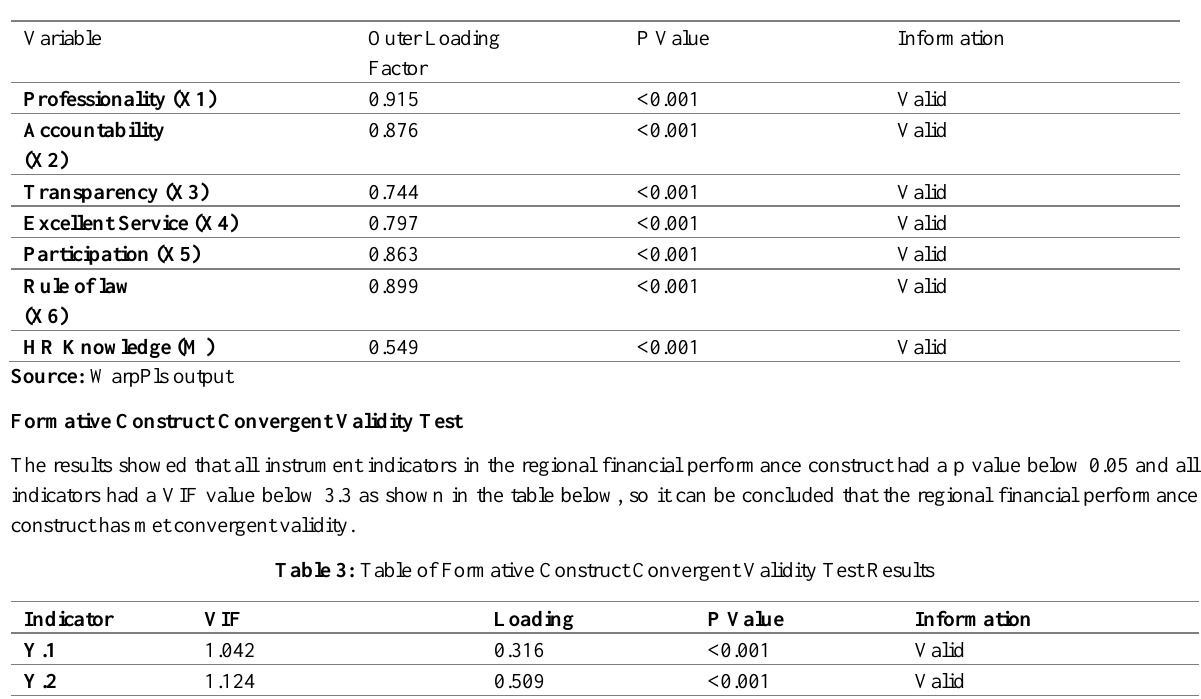
Table 2: Reflective Construct Convergent Validity Test Results